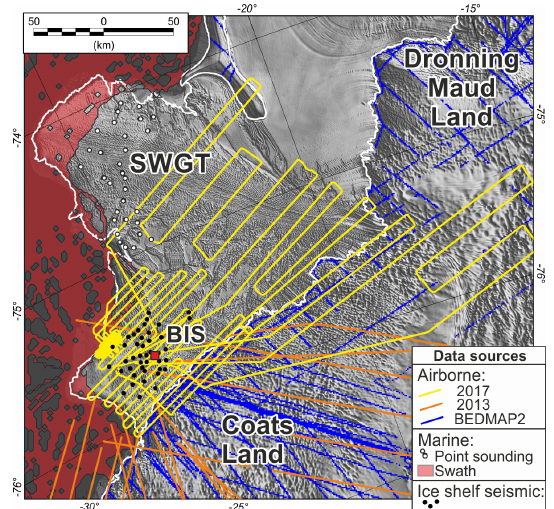
Figure 3. Data locations overlain on MODIS Mosaic of Antarc- tica 2008–2009 (MOA2009) satellite image (Haran et al., 2014). Yellow lines indicate 2017 aerogeophysical flights collecting radar, gravity, and magnetic data. Red shading indicates swath bathymetry data coverage. Blue lines mark radar depth determinations from BEDMAP2 (Fretwell et al., 2013). Orange lines mark the location of ICEGRAV 2013 radar and gravity data (Forsberg et al., 2017). Black dots mark seismic determinations of water column thickness under the Brunt Ice Shelf (Hodgson et al., 2018). The white dots mark soundings from historical ship tracks acquired when the ice front of the Stancomb-Wills Glacier Tongue was less-advanced. The white line marks the grounding line/ice shelf edge from the 2013 Antarctic Digital Database. The red square marks the approximate location of Halley VIa